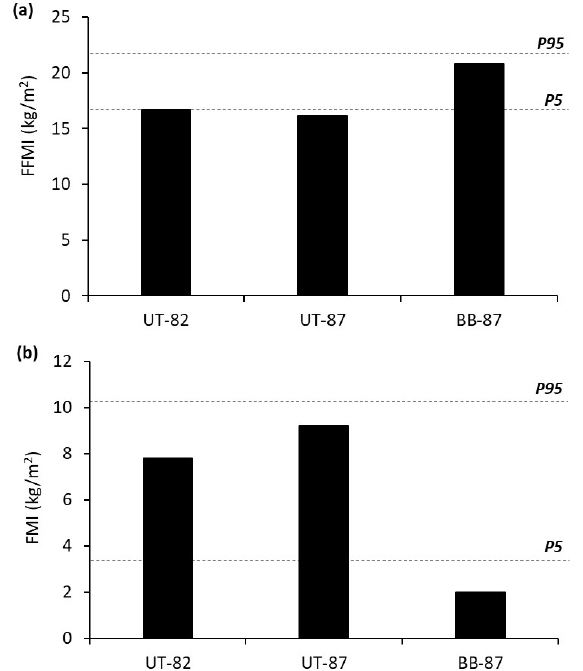
Figure 1. Comparison between the 87-year-old bodybuilder and untrained older males of a similar age for ( a ) fat-free mass and ( b ) fat mass indices. UT-82y = untrained male aged 82 years; UT-87y = untrained male aged 87 years; BB-87y = bodybuilder aged 87 years; FFMI = fat-free mass index; FMI = fat mass index; P95 = 95th percentile; P5 = 5th percentile. For bone mineral density (BMD), BB-87y had osteoporosis (T score < − 2.5) on the fem- Table 1. Differences in bone mineral density and T score for the lumbar spine, total hip, and femoral neck between the 87-year-old bodybuilder and untrained older males of a similar age. Parameter UT-82y Lumbar spine (L2–L4) (g/cm 2 )